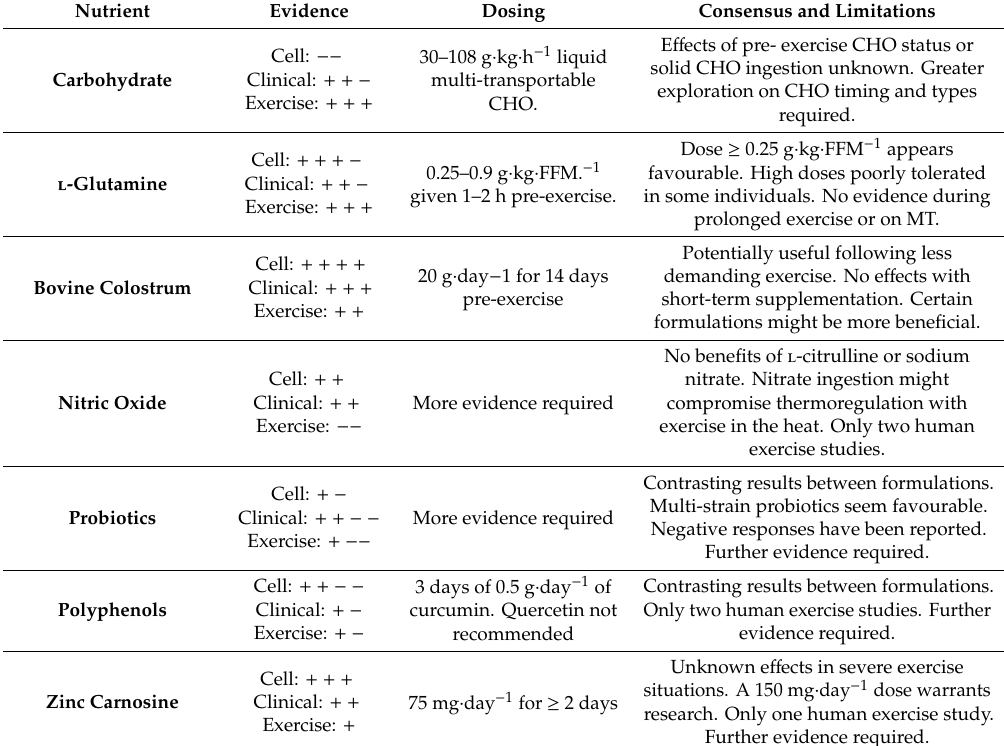
Table 5. Evidence basis of nutritional supplements to help protect exercise-induced GI barrier integrity loss.